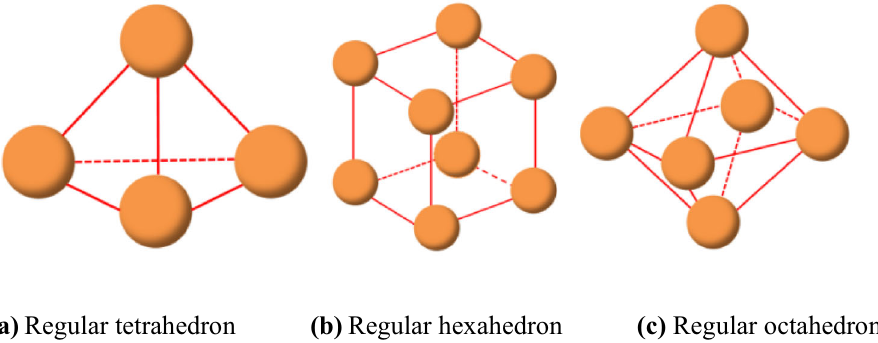
Fig. 3 Granule-centered microstructural units of the weakly cemented sandstone: a regular tetrahedron, b regular hexahedron, c regular octahedron